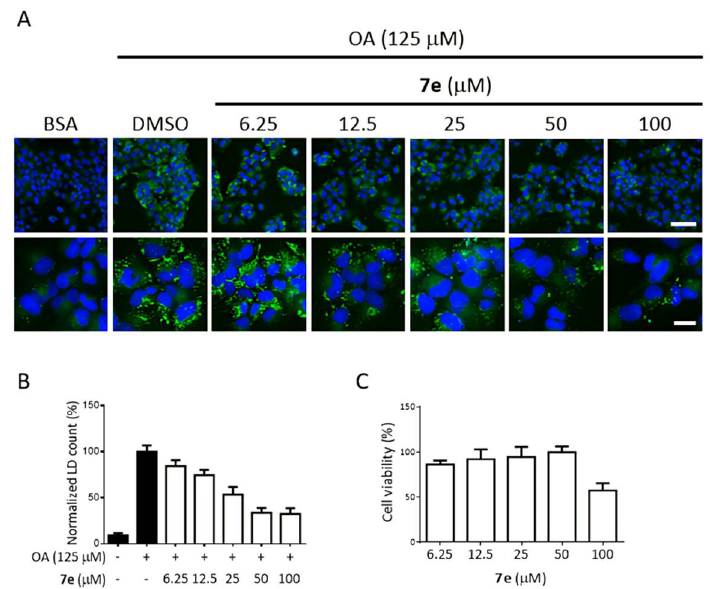
Figure 2. 7e reduced LD accumulation in a dose-dependent manner. ( A , B ) Huh7 cells were treated with either bovine serum albumin (BSA) or BSA-conjugated oleic acid (OA) (125 mM) with the indicated concentrations of 7e for 16 h. Cells were then fixed with paraformaldehyde and stained with 2 µ g/mL of Hoechst 33342 and 1 µ g/mL of BODIPY ® 493/503. ( A ) Representative images. Scale of upper row: 100 µ m. Scale of lower row: 25 µ m. ( B ) Quantification results. The IC 50 of 7e was 32.2 ± 2.1 µ M. ( C ) The cytotoxicity of 7e in Huh7 cells. Huh7 cells were treated with a series of concentrations of 7e for 72 h. Cell viability was measured by alamarBlue ® reagent according to the manufacturer’s protocol. The results showed that the CC 50 of 7e was higher than 100 µ